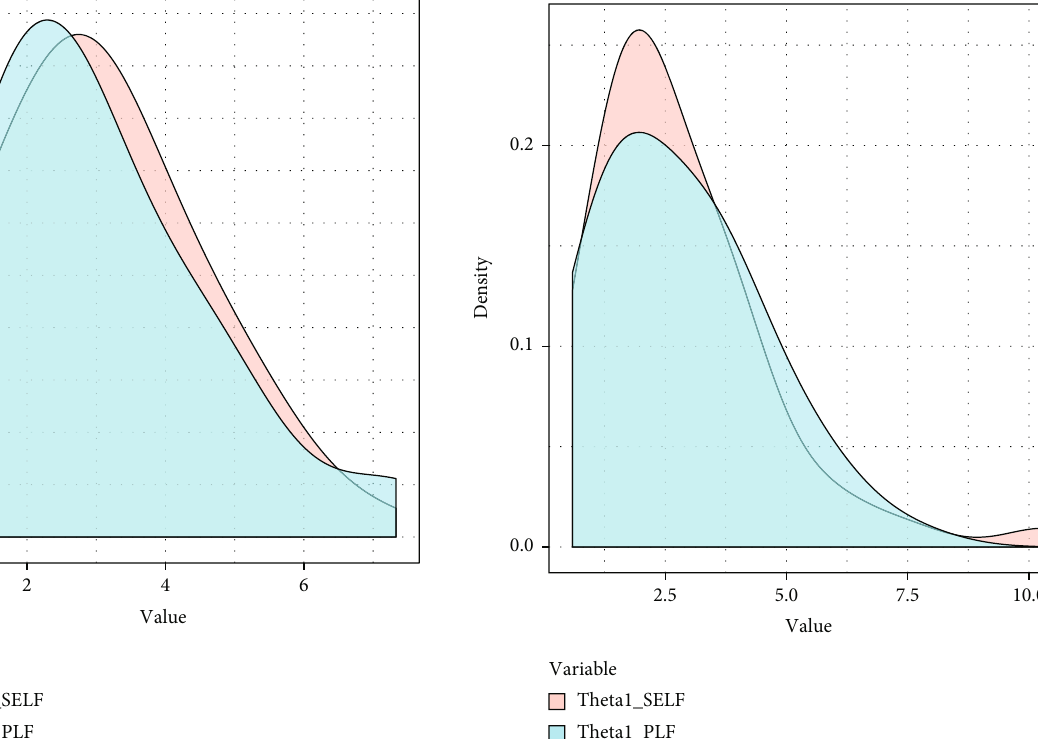
Figure 5: The marginal density for θ